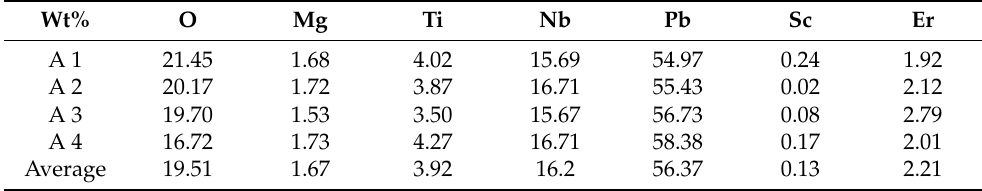
Table 1. the element content of the PMN-32PT:Er 3+ /Sc 3+ crystal obtained by EDS. Wt% O Table 1. The element content of the PMN-32PT:Er 3+ /Sc 3+ crystal obtained by EDS. Wt%